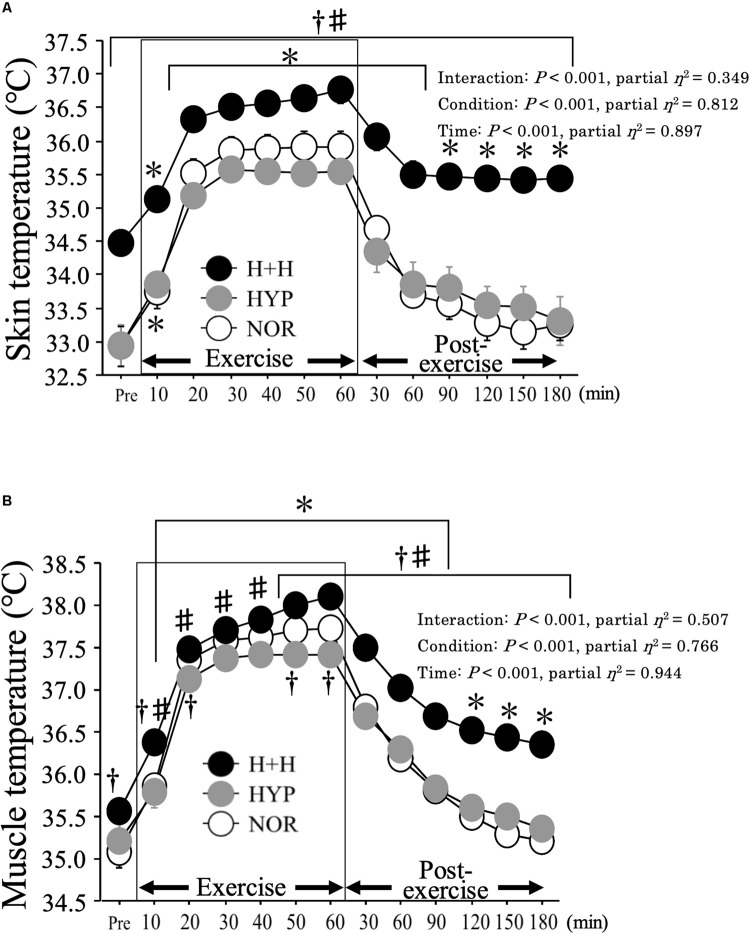
Skin (A) and muscle (B) temperatures during exercise and post-exercise. Values are means ± SE. ∗P < 0.05 vs. Pre. †P < 0.05 vs. NOR. #P < 0.05 vs. HYP. Shadow box indicates exercise duration.